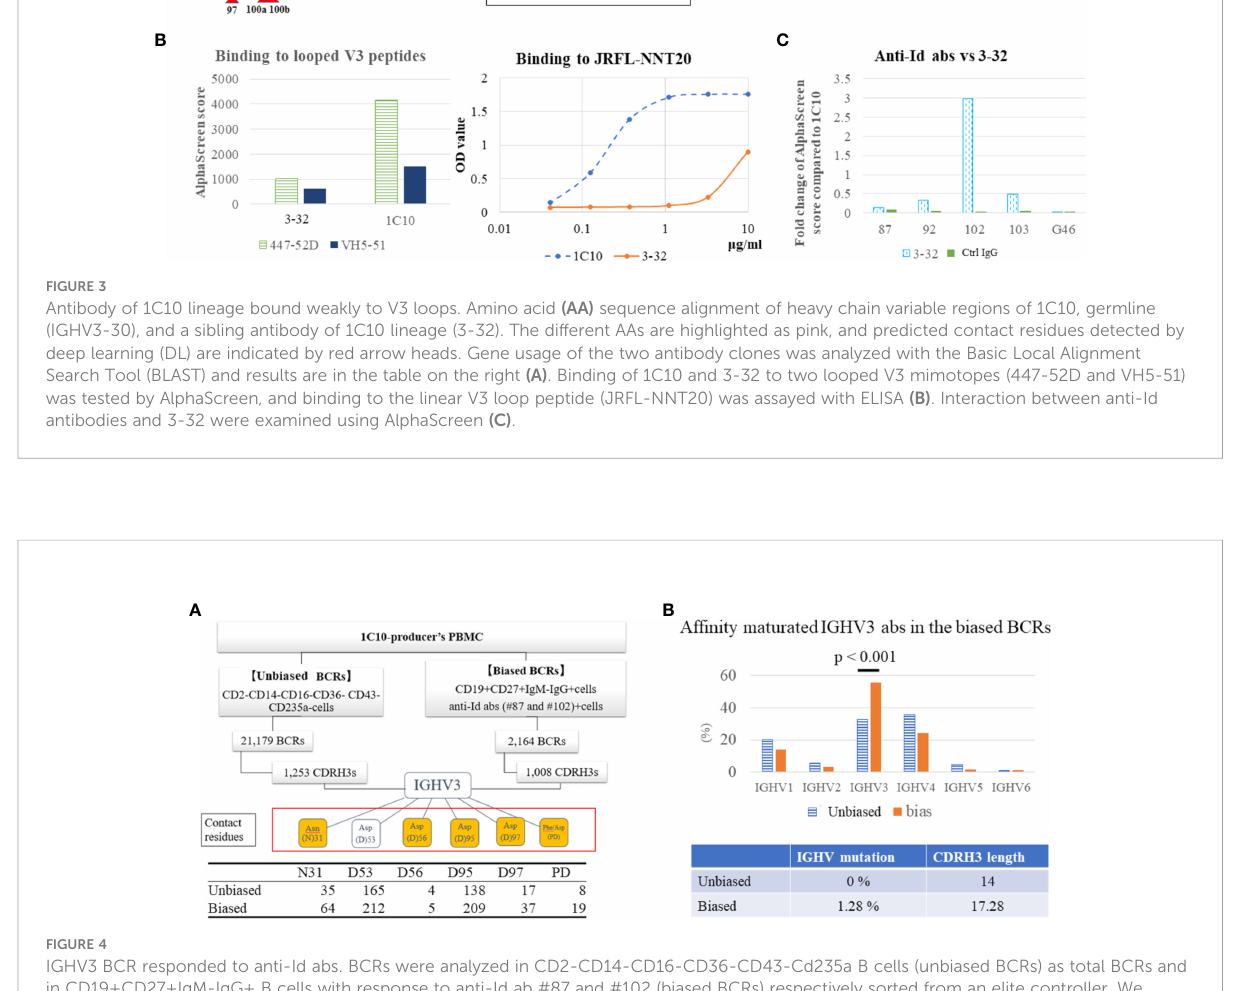
FIGURE 4 IGHV3 BCR responded to anti-Id abs. BCRs were analyzed in CD2-CD14-CD16-CD36-CD43-Cd235a B cells (unbiased BCRs) as total BCRs and in CD19+CD27+IgM-IgG+ B cells with response to anti-Id ab #87 and #102 (biased BCRs) respectively sorted from an elite controller. We obtained 1,253 CDRH3s from unbiased BCRs and 1,008 CDRH3s from biased BCRs. Finally, we analyzed fi ve aspartic acid (Asp) residues and one asparagine (Asn) residue at the same positions as contact residues of 1C10 in IGHV3 abs. Amino acids (AAs) in orange boxes are mutated AAs from germline, of which N31 is located in CDR2, and sequential phenylalanine (Phe) and Asp residues (PD) are considered mutated AAs corresponding to P100a and D100b. The table at the bottom shows the number of IGHV3 CDRH3 regions containing each residue (A) . Unbiased and biased BCRs were compared for genes encoding immunoglobulin heavy chain variable (IGHV) regions, mutation ratio of AAs of IGHV, and length of CDRH3 (B)